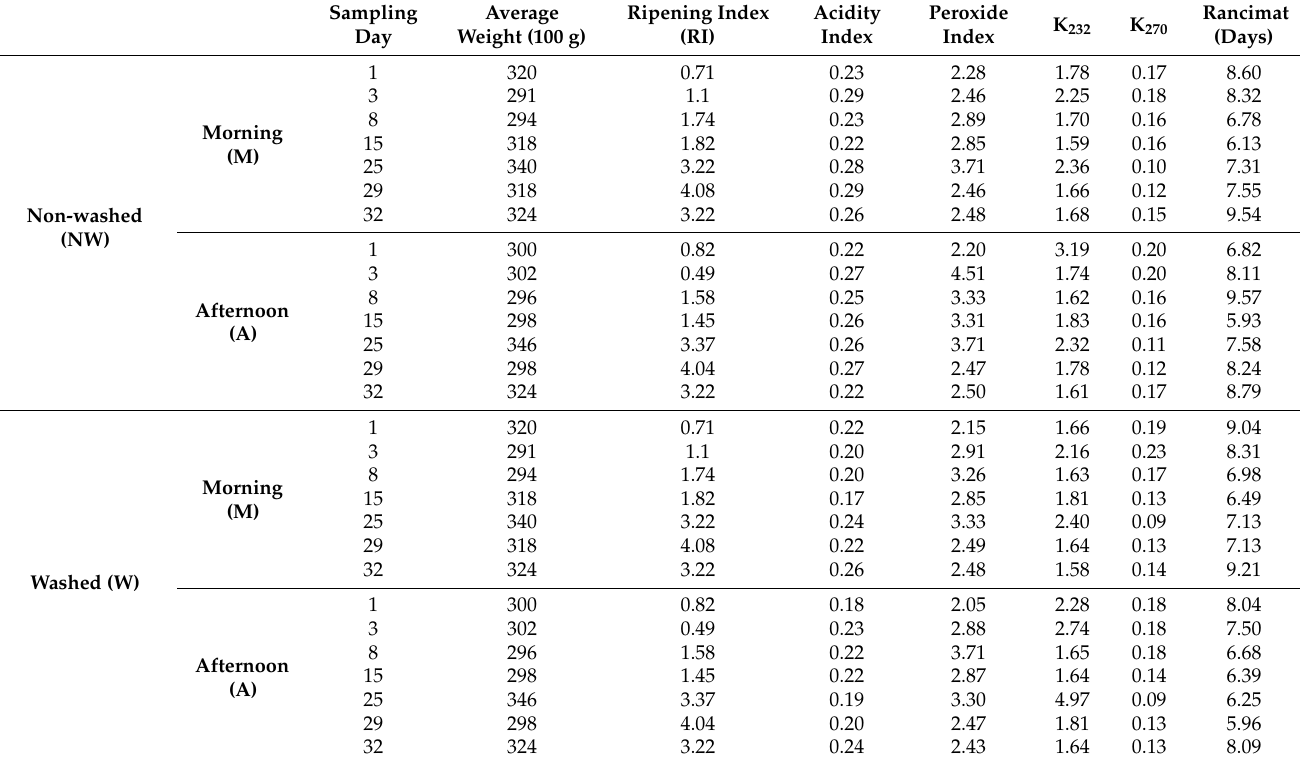
Table 1. Agronomic and physicochemical parameters of Picual Organic Extra Virgin Olive Oil (OEVOO) samples depending on the sampling day (1, 15 and 32) and the time of collection (morning or afternoon) and the washing